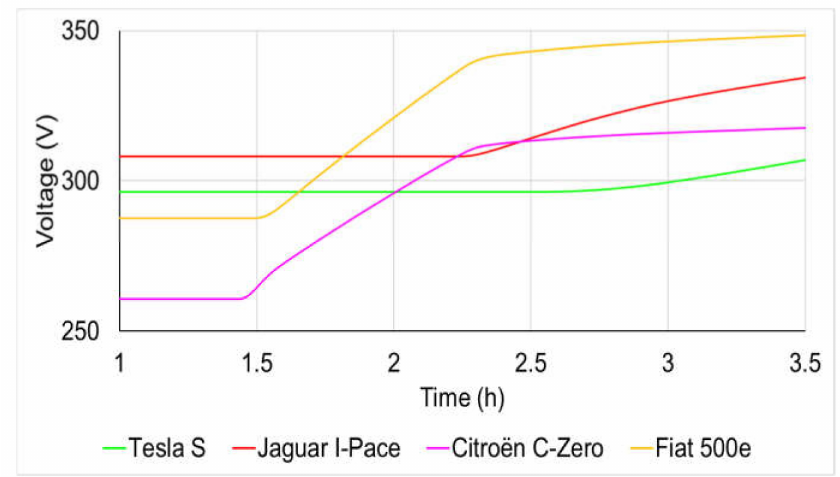
Figure 6. Charging profiles of the four cars requesting the same amount of charge. A third scenario now considers ten cars, except that two of them are the same but request different amounts of charge (a more common scenario). The data for this is shown in Table 7. Table 7. Two identical VW e-up requesting a different amount of charge.